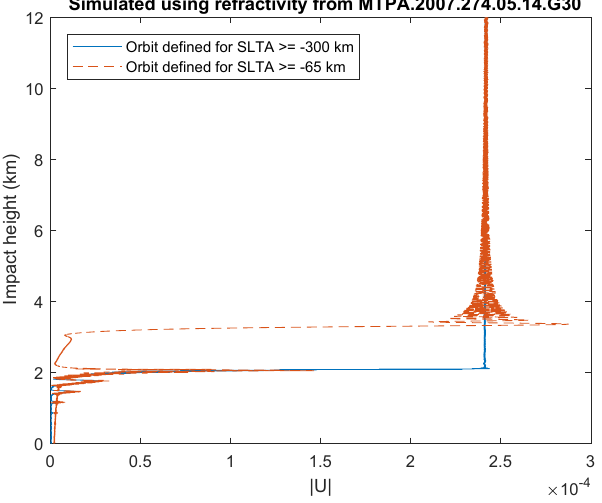
Figure 2. | U | for a simulated signal that is propagated to a shal- low orbit and one that is propagated to a deeper orbit (blue). For illustration the truncated signal is not tapered, producing dramatic oscillations around